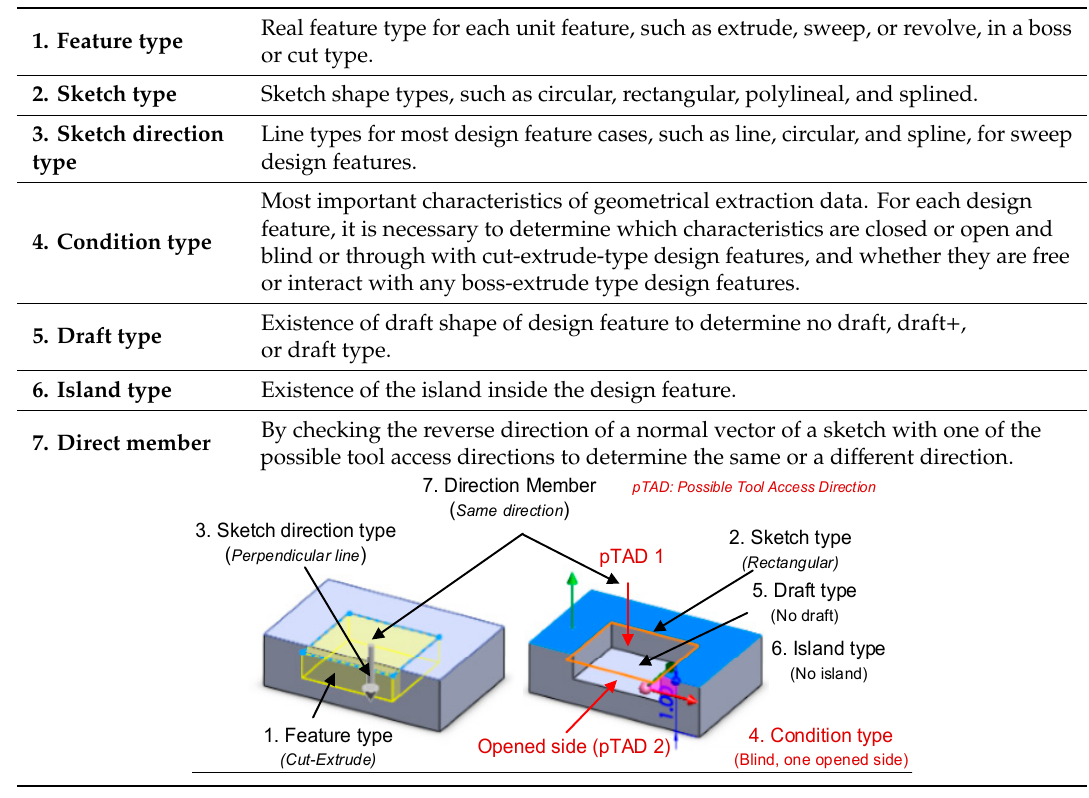
Table 2. Examples of technical requirement extraction